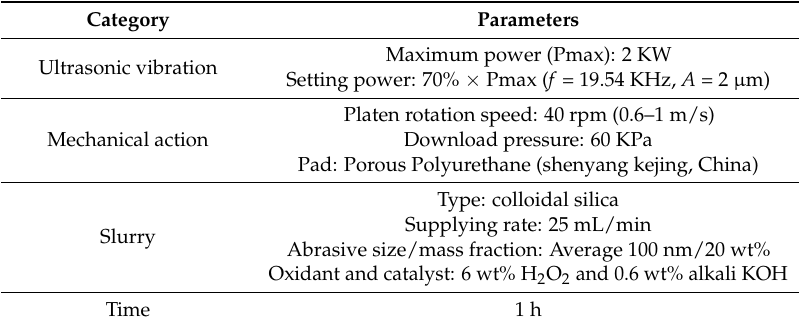
Table 3. Experimental conditions for